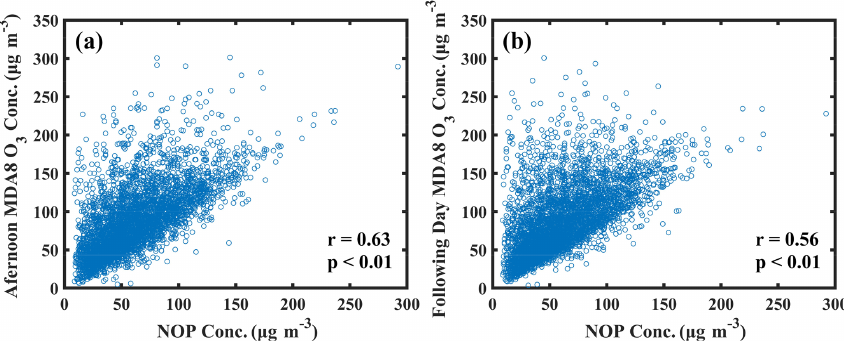
Figure 12. Correlation between (a) the afternoon’s MDA8 O 3 concentration and the following night’s NOP concentration and (b) the NOP concentration and the following afternoon’s MDA8 O 3